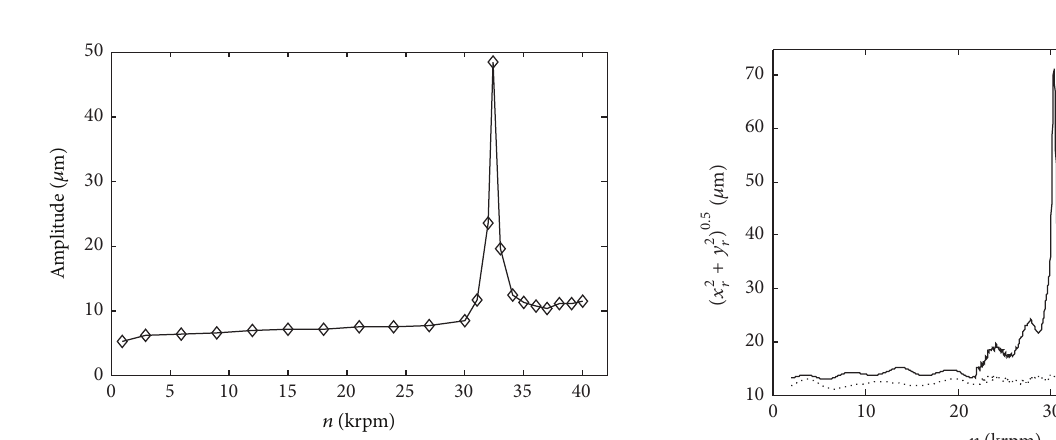
Figure 5: Experimental vibration signals of the front end of spindle in 𝑦 -direction.